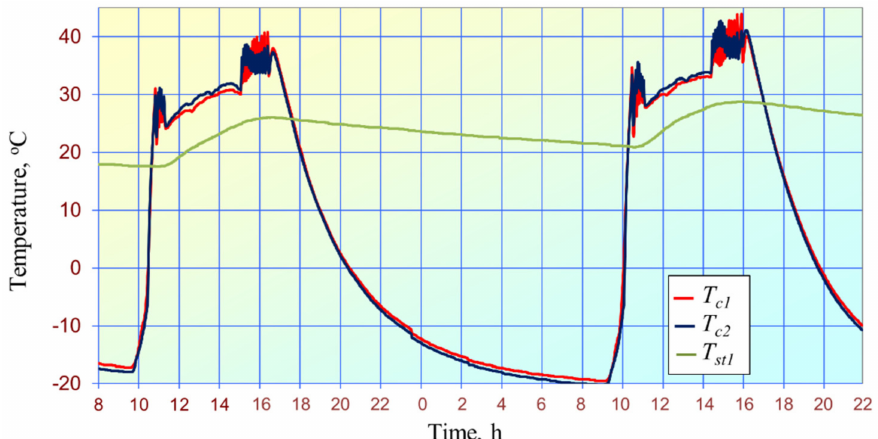
Figure 11. The time dependence of heating agent in collectors and water in the storage tank (26–27 November 2020).